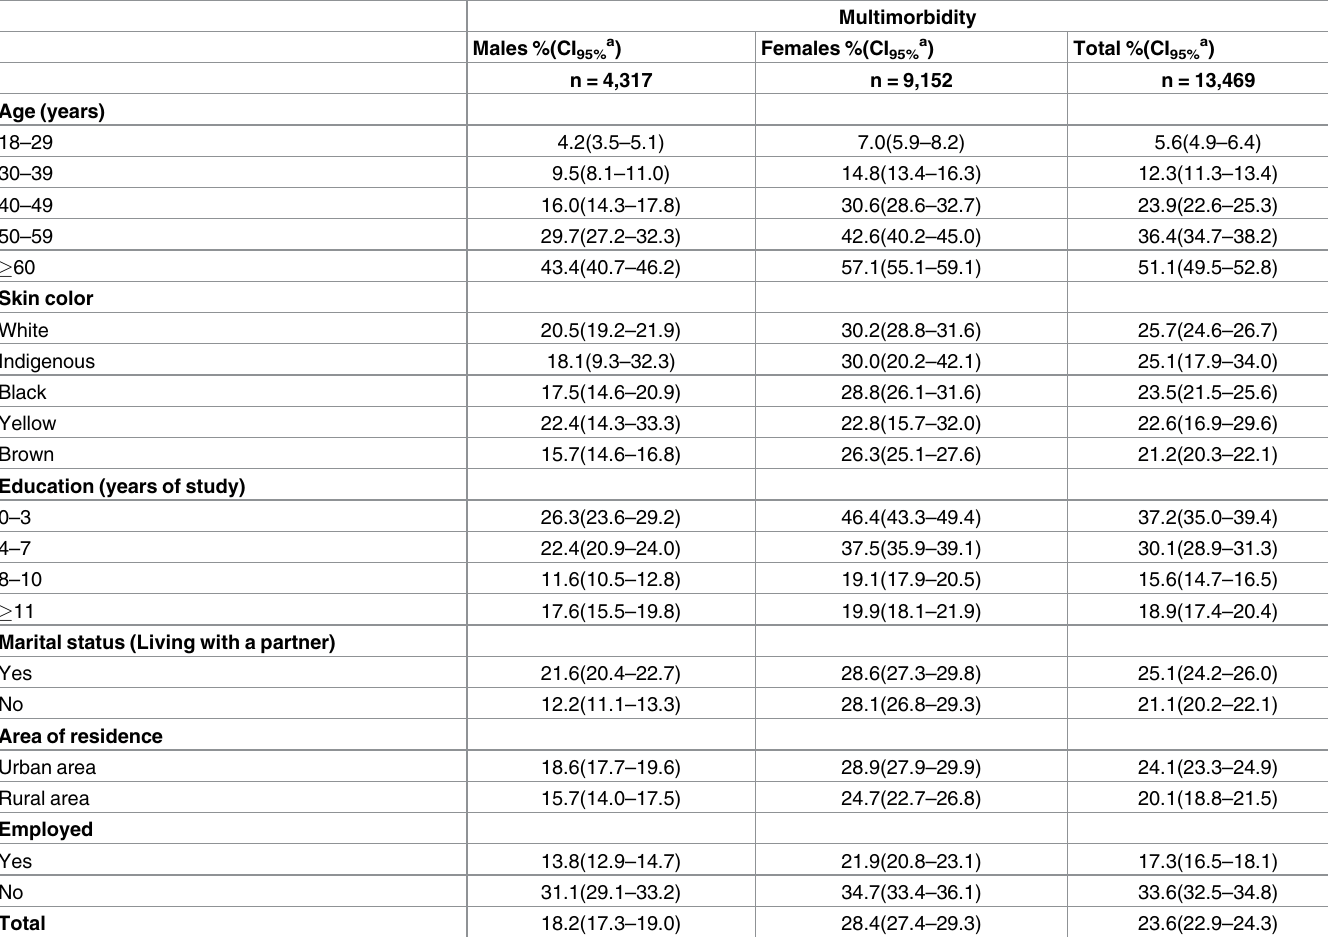
Table 1. Prevalence(%) of multimorbidity according to socioeconomic characteristics by sex. NHS, Brazil. 2013.